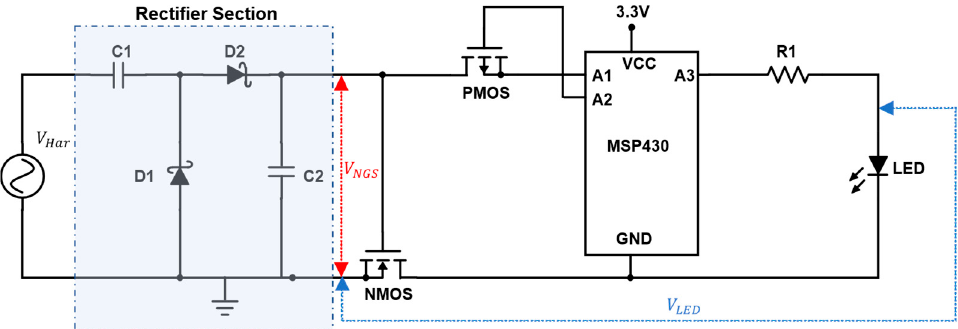
Figure 5. Wakeup circuitry schematic. Refer to text for details.